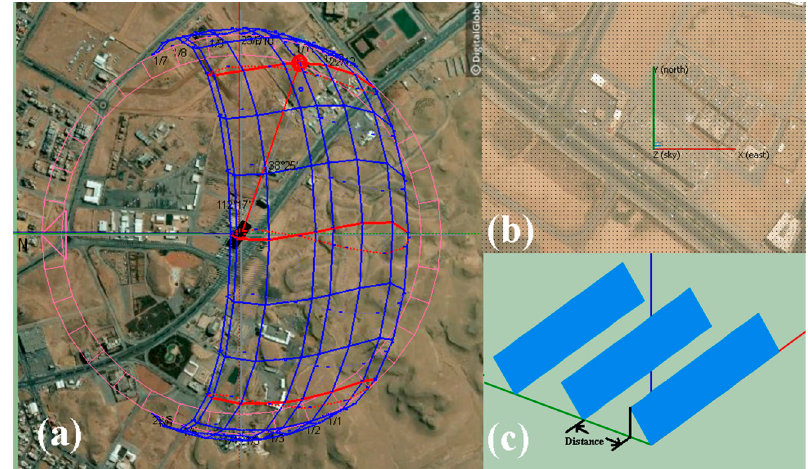
Figure 6. Study of self-shading by SAM ( a ) Sun path diagram over College of Engineering building in SketchupPro; ( b ) Bird’s eye view of College of Engineering in SAM; ( c ) 3D scene of placing active surfaces (PV panels) in SAM, where the distance between two parallel arrays is shown.